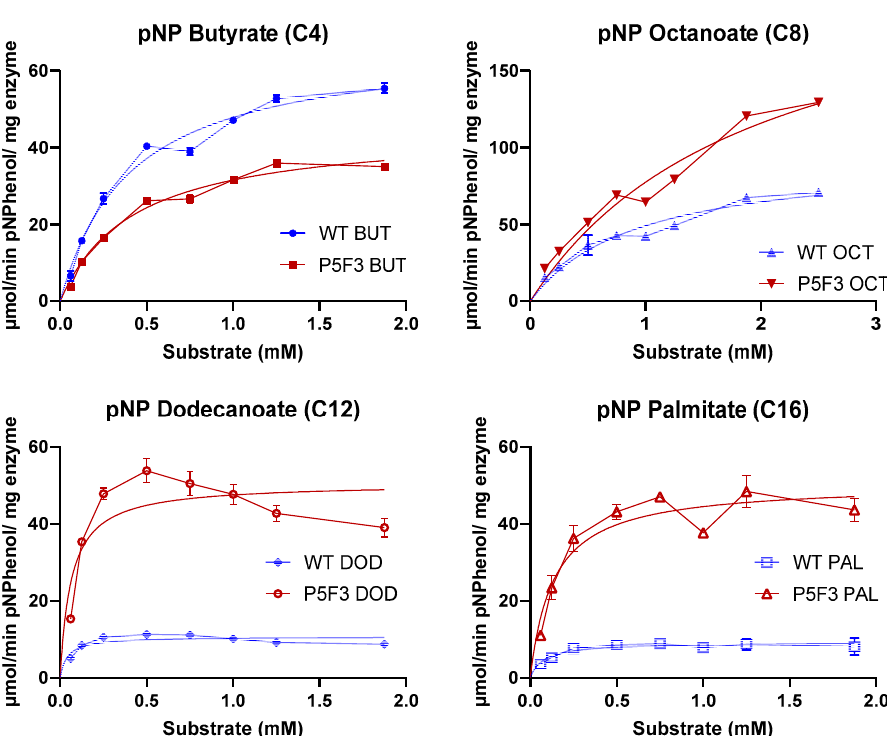
Figure A2. Substrate saturation assays to estimate kinetic parameters of wildtype BSLA and variant P5F3. Enzymatic activity reactions for p -nitrophenyl butyrate, octanoate, dodecanoate, and palmitate by measuring the initial rate of reaction (linear range) in microtiter plates as described above at a concentration of 0.06, 0.125, 0.25, 0.5, 0.75, 1.0, 1.25, and 1.875 mM (2.5 mM for pNPO). Initial hydrolysis rates were calculated as µmol of released p -nitrophenol per mg of enzyme per minute. For